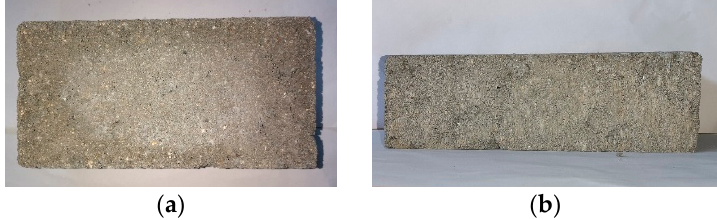
Figure 7. Front and side faces of one concrete paving block. ( a ) plan view of a concrete paving block; ( b ) lateral view of a concrete paving block.